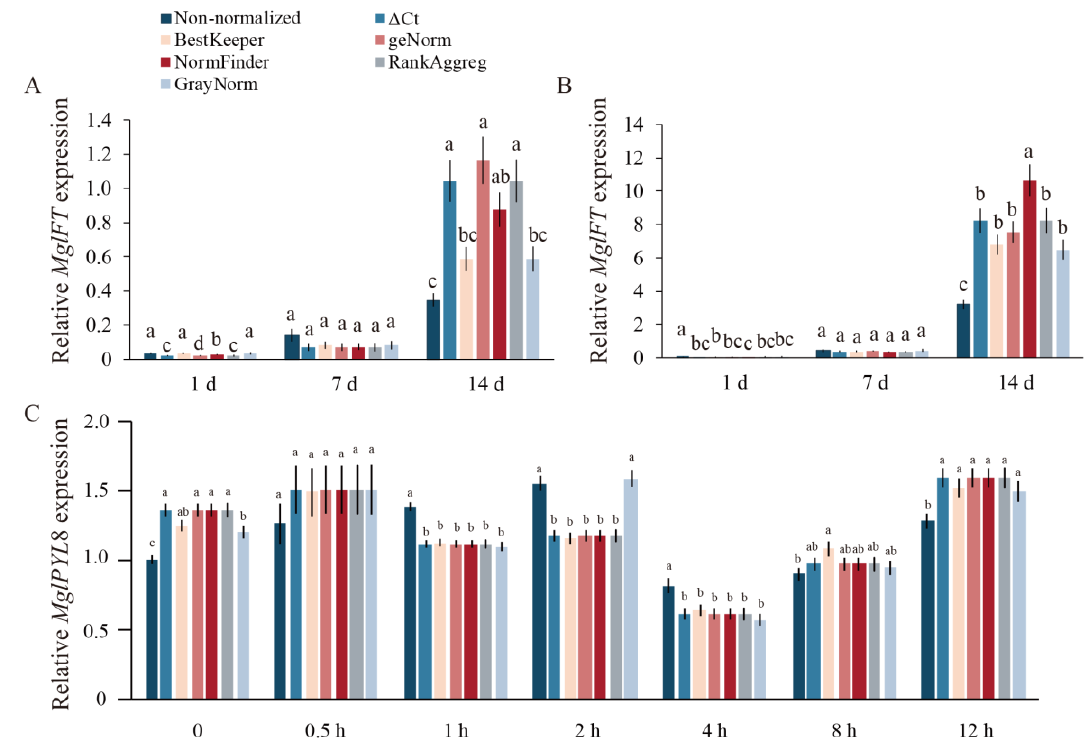
Figure 7. Relative expression levels of two target genes under Mgl Flora treatment and ABA treatment. MgFT expression levels in leaf of Mgl Flora treatment ( A ) and bud of Mgl Flora ( B ), MgPYL8 expression levels under different ABA treatment ( C ), based on the recommendations of six different algorithms. Error bars indicate standard errors of three replicates (bars ± SE).